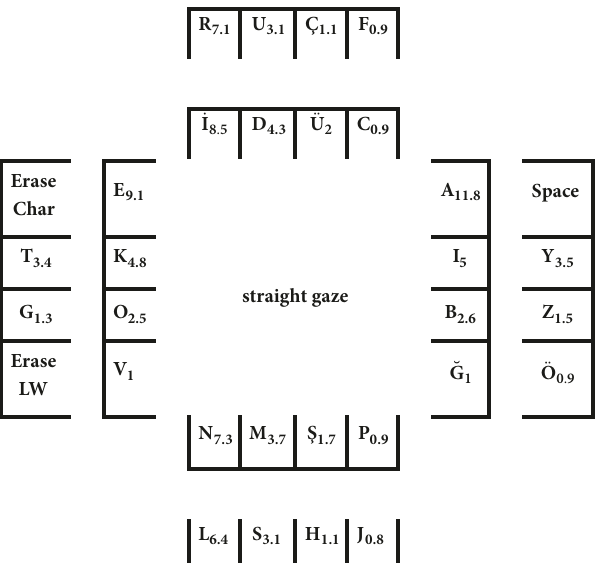
Figure 3: Sorting of characters in the proposed encoding method. Dwell times increase from right to left and top to bottom for character choosing. In addition the usage rates of characters in Turkish alphabet in text are indicated as the subindex of letters.